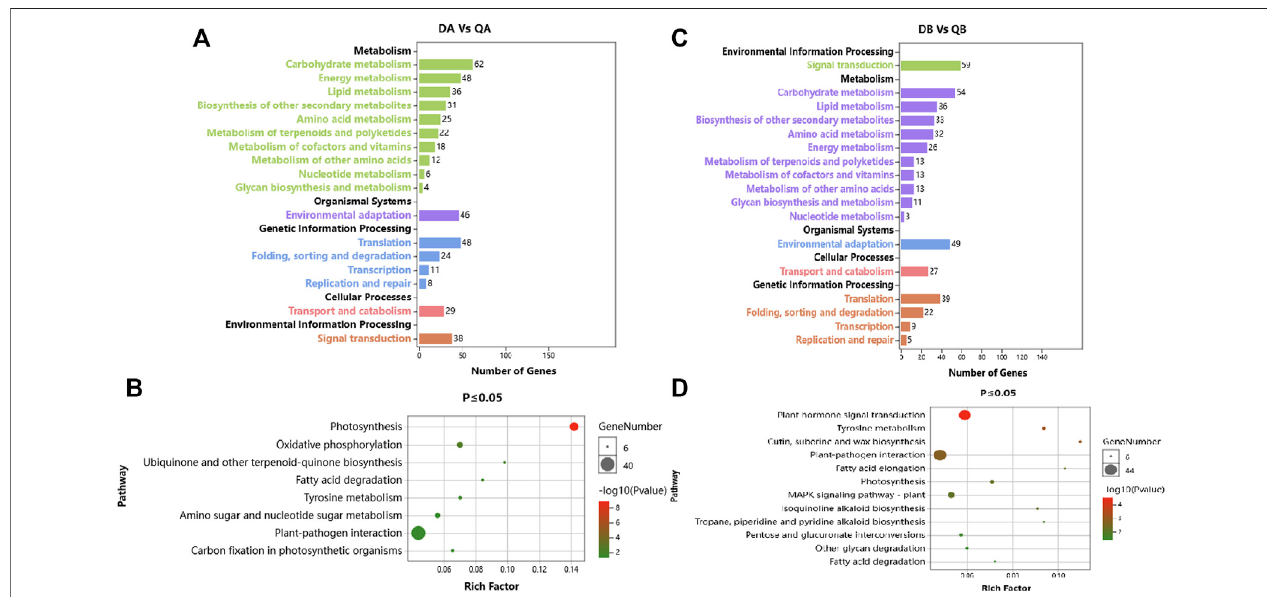
FIGURE 6 | KEGG annotation of DEGs from a comparison of the transcriptomes of proplar trees grown at Daqing with trees from Qiqihar. (A) . KEGG pathway annotationofDaqingvs.QiqiharforABJ01; (B) .PathwayenrichmentofDaqingvs.QiqiharforABJ01at p ≤ 0.05; (C) .KEGGpathwayannotationofDaqingvs.Qiqiharfor 9#; (D) . Pathway enrichment of Daqing vs. Qiqihar for 9# at p ≤